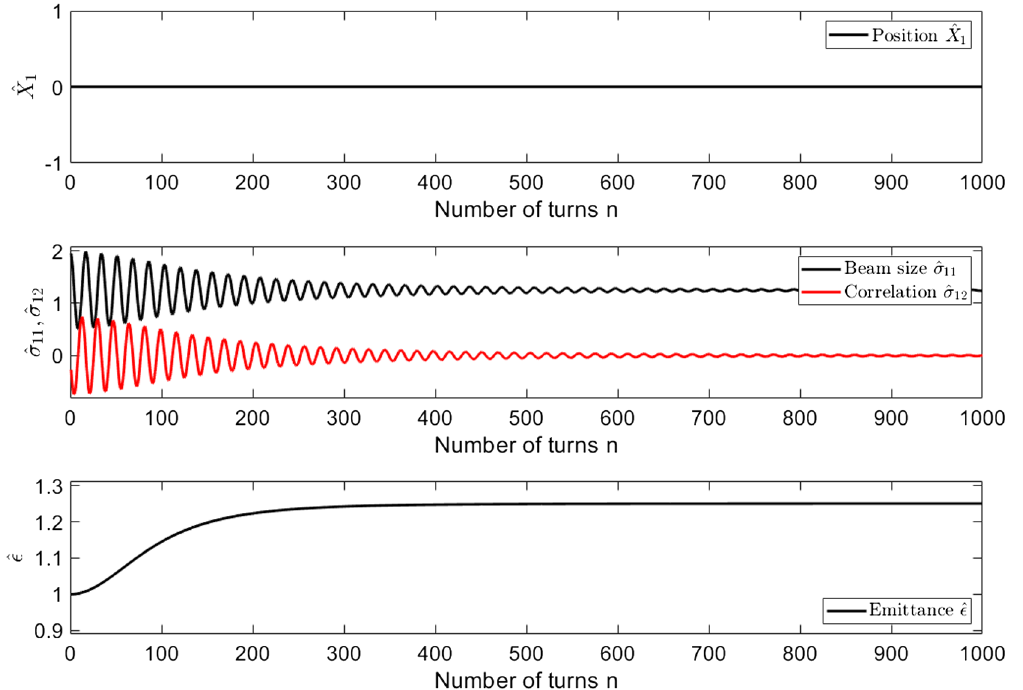
ˆ X ˆ σ ˆ σ FIG. 3. The parameters 1 , 11 , and 12 and emittance as a function of the turn number n for a beam that is injected on axis but with a beta function β 0 that is twice the matched value β . All other parameters are equal to those used in Fig. 2. The vertical axes are normalized to appropriate powers of ε 0